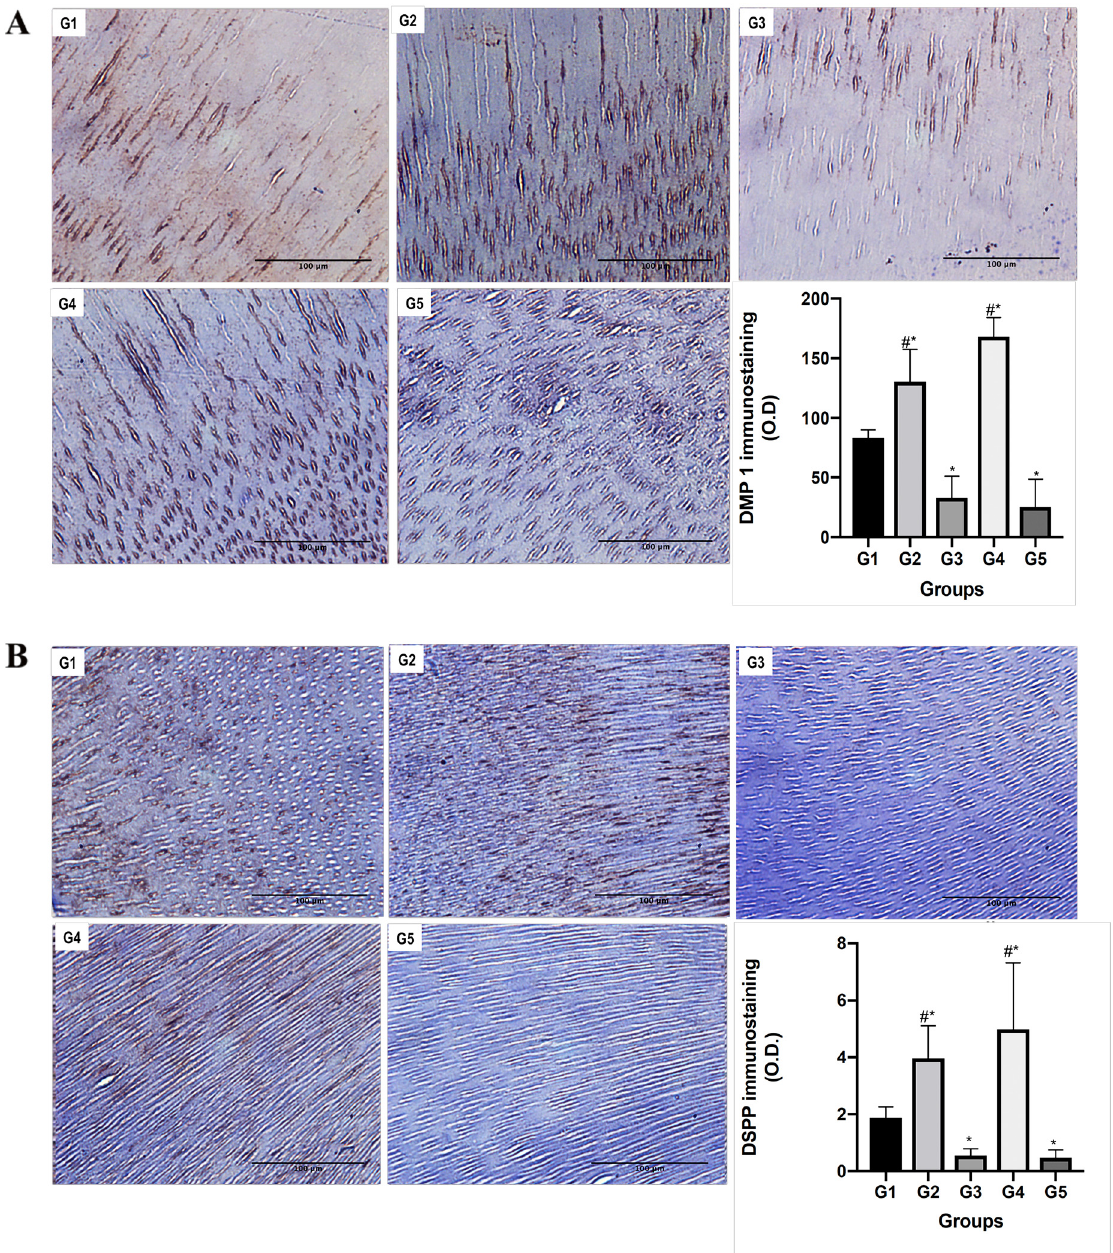
(control group). # p < 0.05 versus G3.